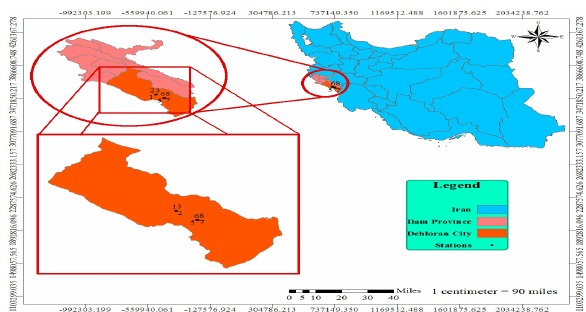
Fig.1 Location of the study sites The map showing location of study sites.